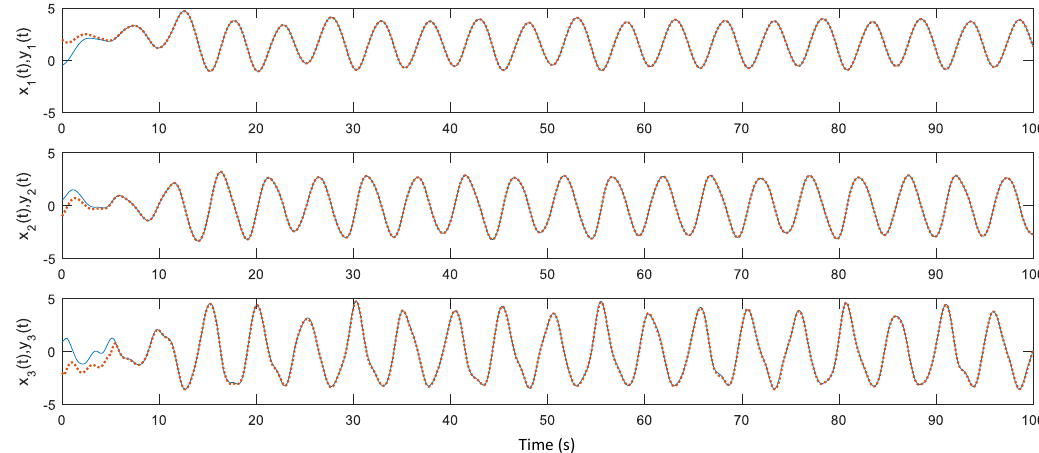
Figure 4. Representation of the robust synchronization presses of the master and slave systems (25), (26) based on the proposed adaptive control strategy where it is activated at 𝑡 = 5 s .